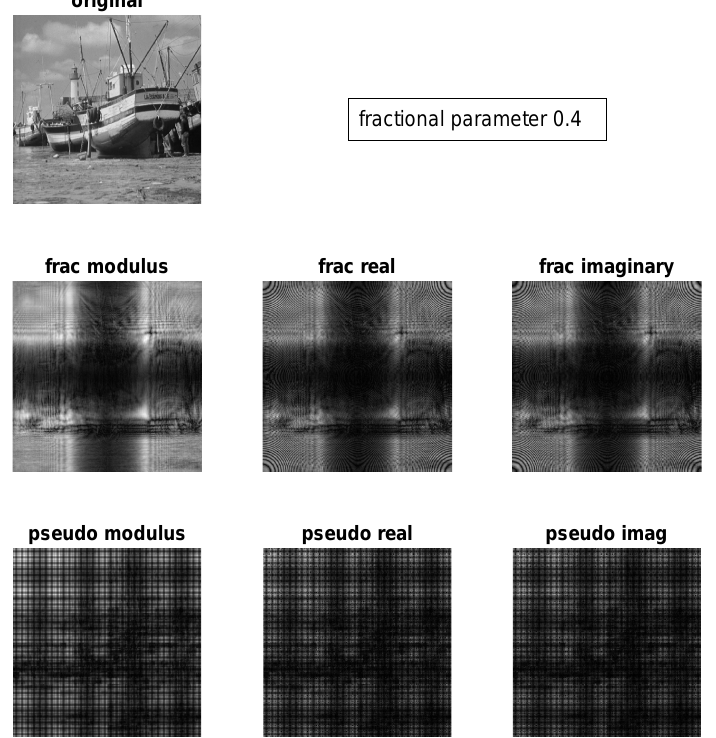
Figure 8. Comparison of DFrFT and DPFrFT of the grayscale image “Boat” for fractional parameter a =